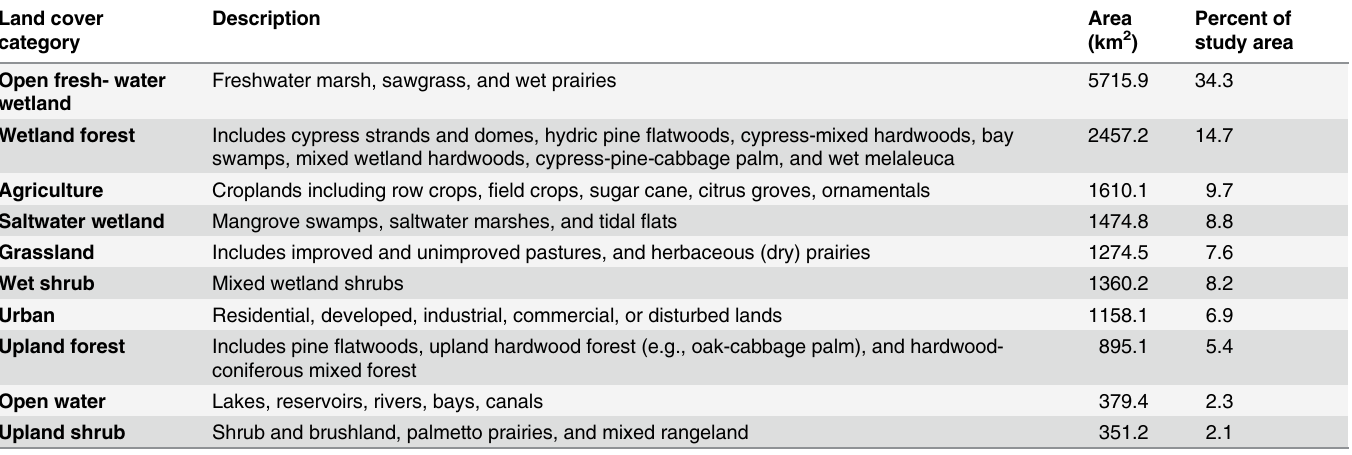
Table 1. Land cover categories used as explanatory variables and their extent in the study